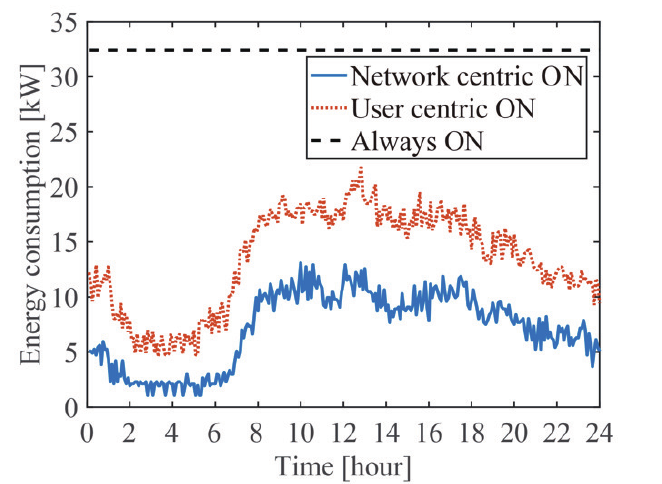
Figure 8. Numerical performance of total energy